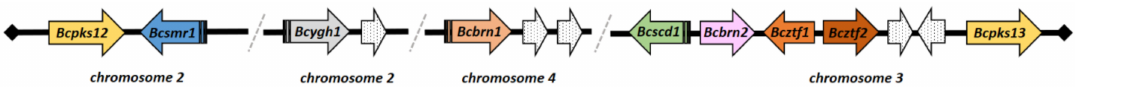
Figure 7. Melanogenic genes from B. cinerea